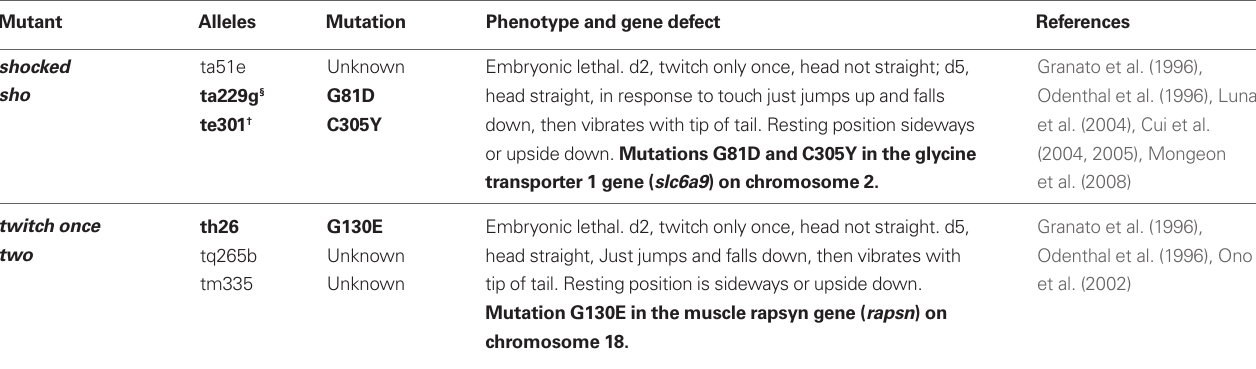
Table 2 | Twitch once mutants. Mutant